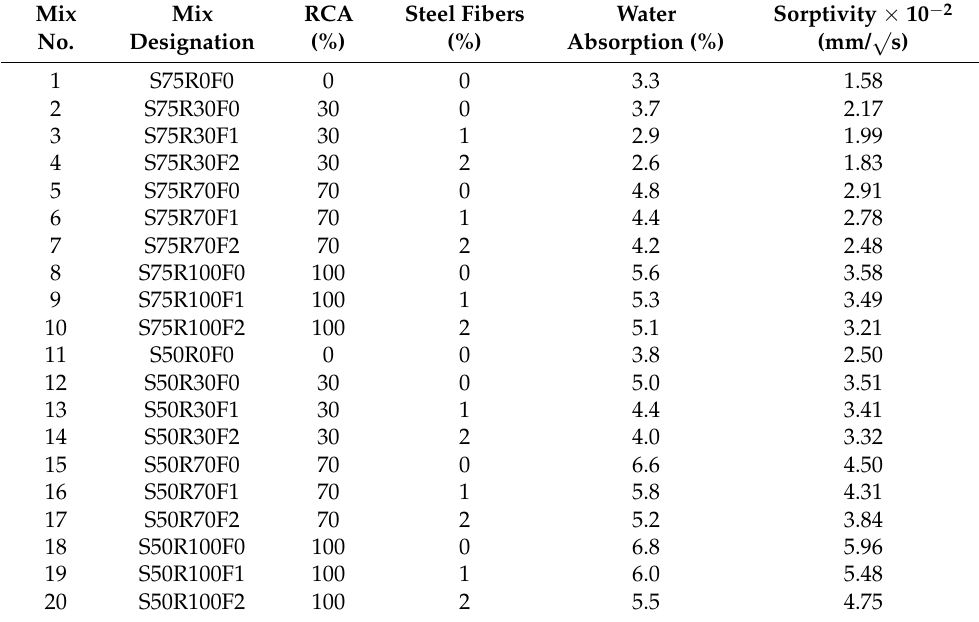
Table 6. Water absorption and sorptivity of alkali-activated slag-fly ash blended concrete